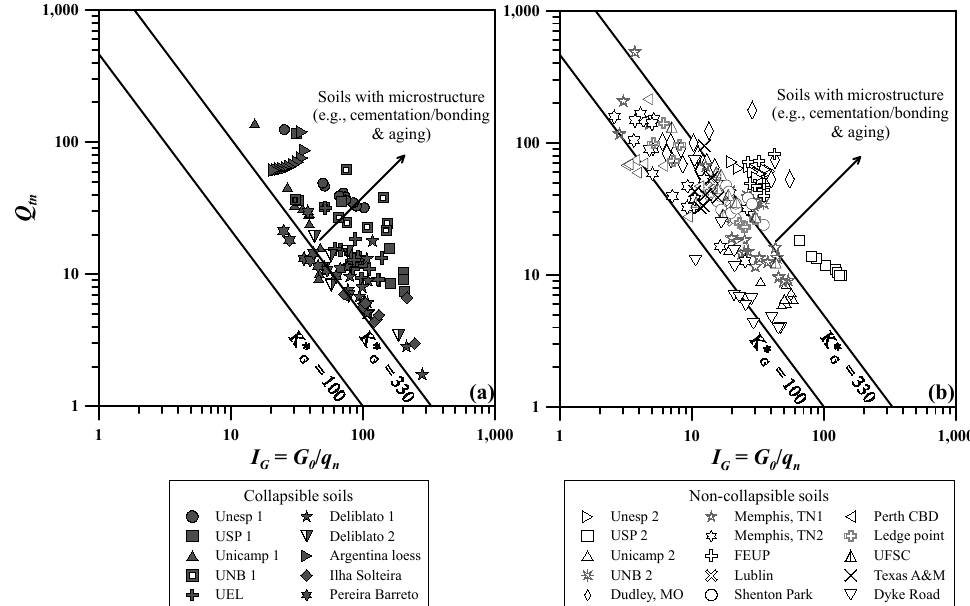
Figure 2. Q tn versus I G chart to identify collapsible ( a ) and non-collapsible ( b ) soils with microstructure .